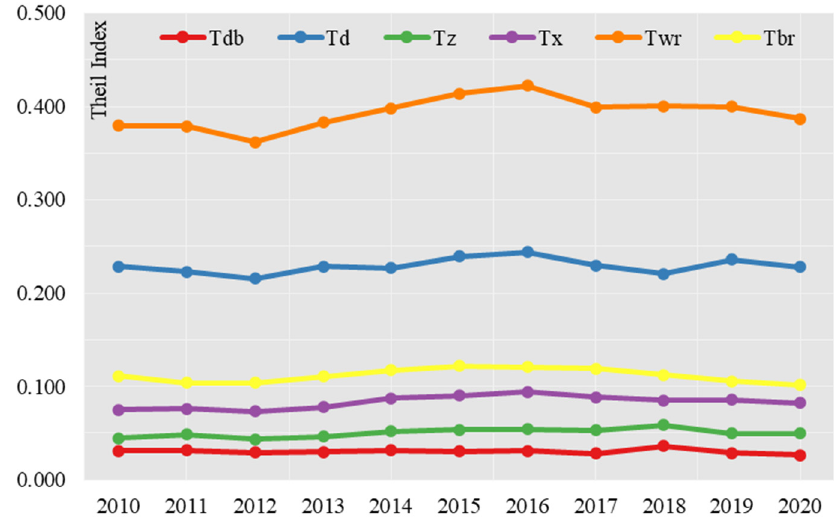
Table 2. Theil Index from 2010 to 2020.